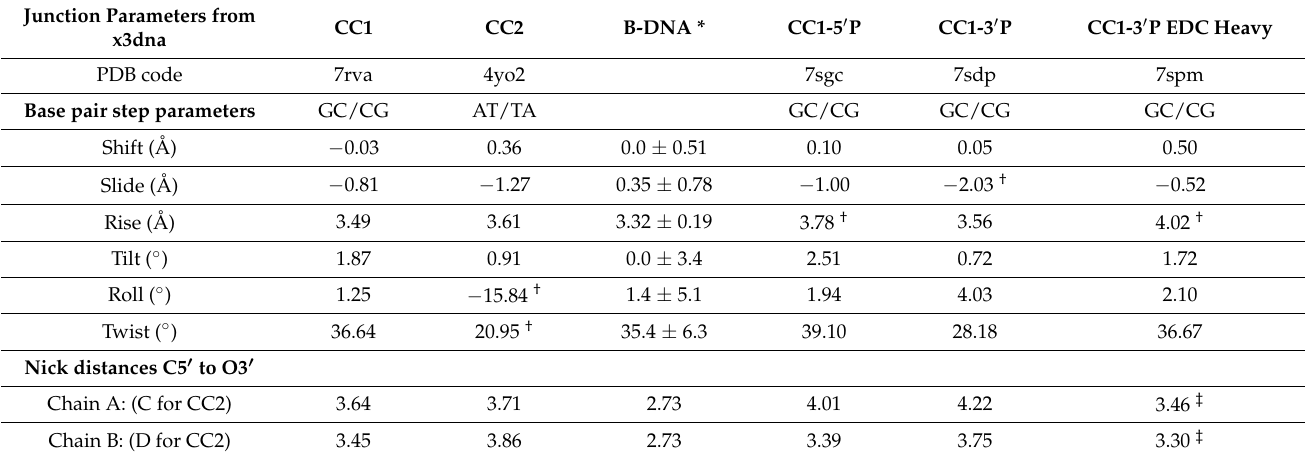
Table 3. DNA–DNA junction geometry parameters before and after phosphorylation and ligation. The likelihood of successful chemical ligation for stacked DNA may depend on geometry details across the junction. Here, we compare the geometry of the junction in the parent PDB models for CC1 and CC2, as well as the blunt-ended 5 (cid:48) or 3 (cid:48) phosphorylated CC1 crystals, to the geometry of contiguous bases in idealized B-DNA from Olson et al., 1998 [30]. The junctions are not symmetric, and differing distances for the two nicks across the junctions are also